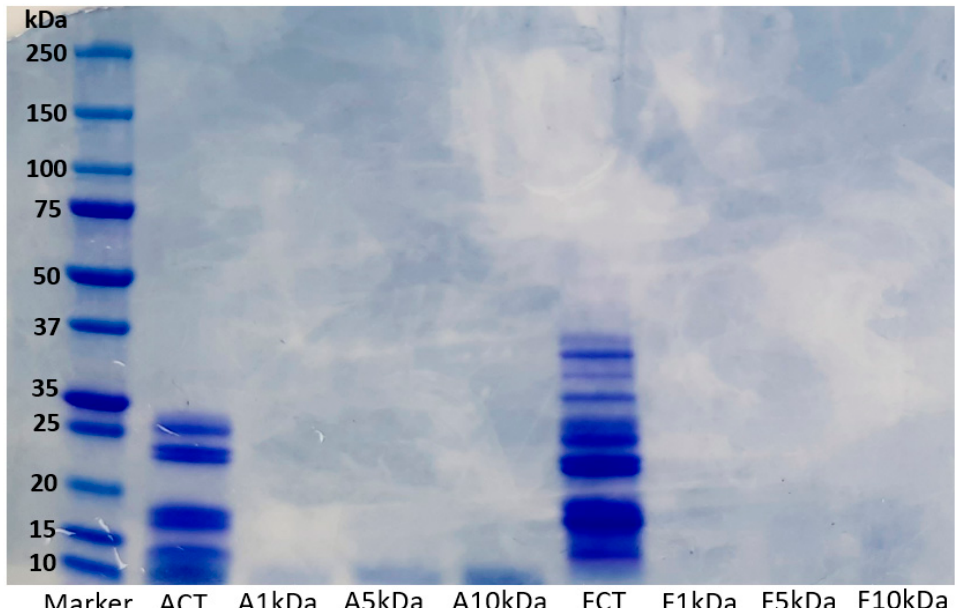
Figure 1. Electrophoretic pattern of LPHs generated using alcalase and flavourzyme and their ultrafiltrated fractions. ACT, unfractionated alcalase hydrolysate; FCT, unfractionated flavourzyme hydrolysate; A1 kDa and F1 kDa, <1 kDa fraction; A5 kDa and F5 kDa, <5 kDa fraction; A10 kDa and F10 kDa, <10 kDa fraction.